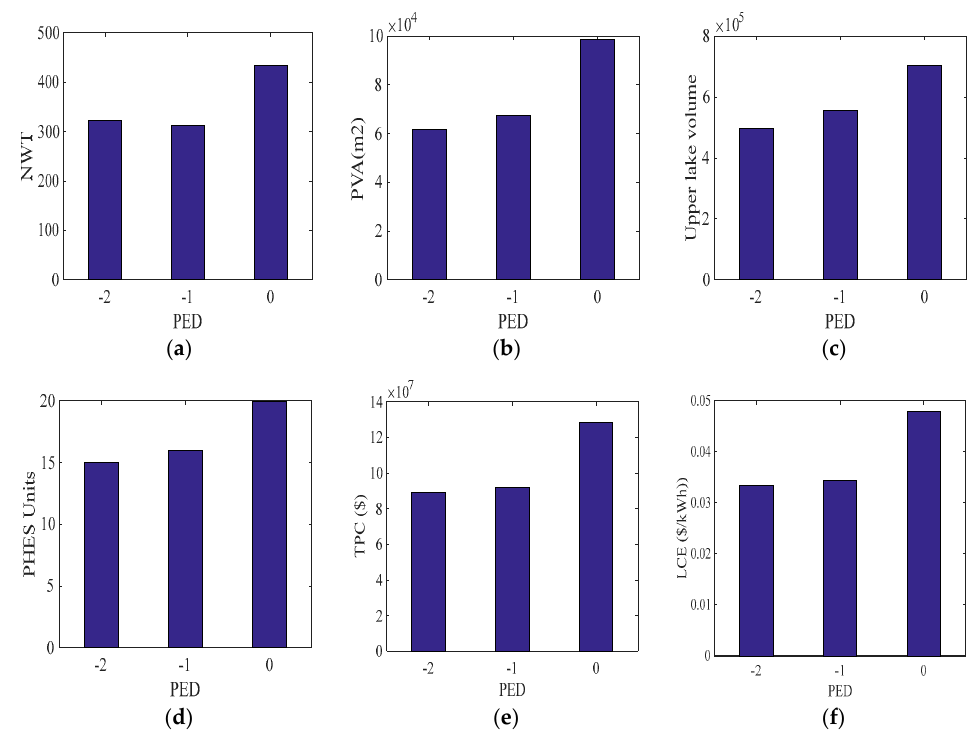
Figure 12. The variation of different performance parameters with PED values. ( a ): NWT . ( b ): PVA . ( c ): Upper lake volume.( d ): PHES Units. ( e ): TPC . ( f ): LCE . Table 7. The change in system size components with different values of PED , 0 (flat tariff), − 1, − 2,